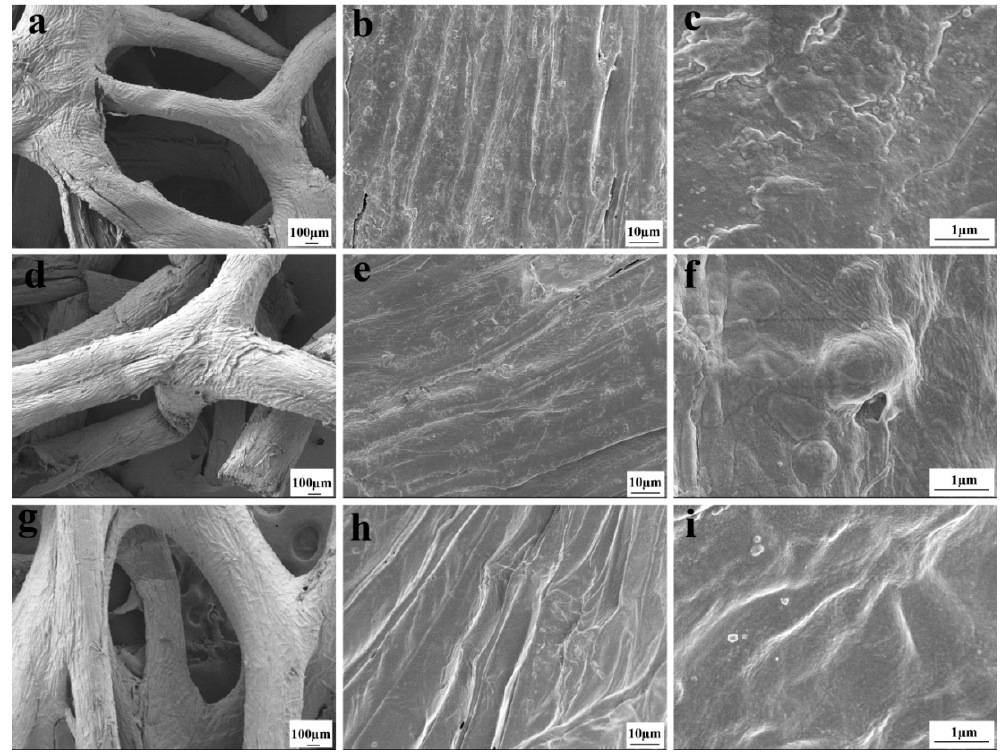
Figure 2. SEM images of LS@SA-0 ( a – c ), LS@SA-1.0 ( d – f ) and LS@SA-2.0 ( g – i ).